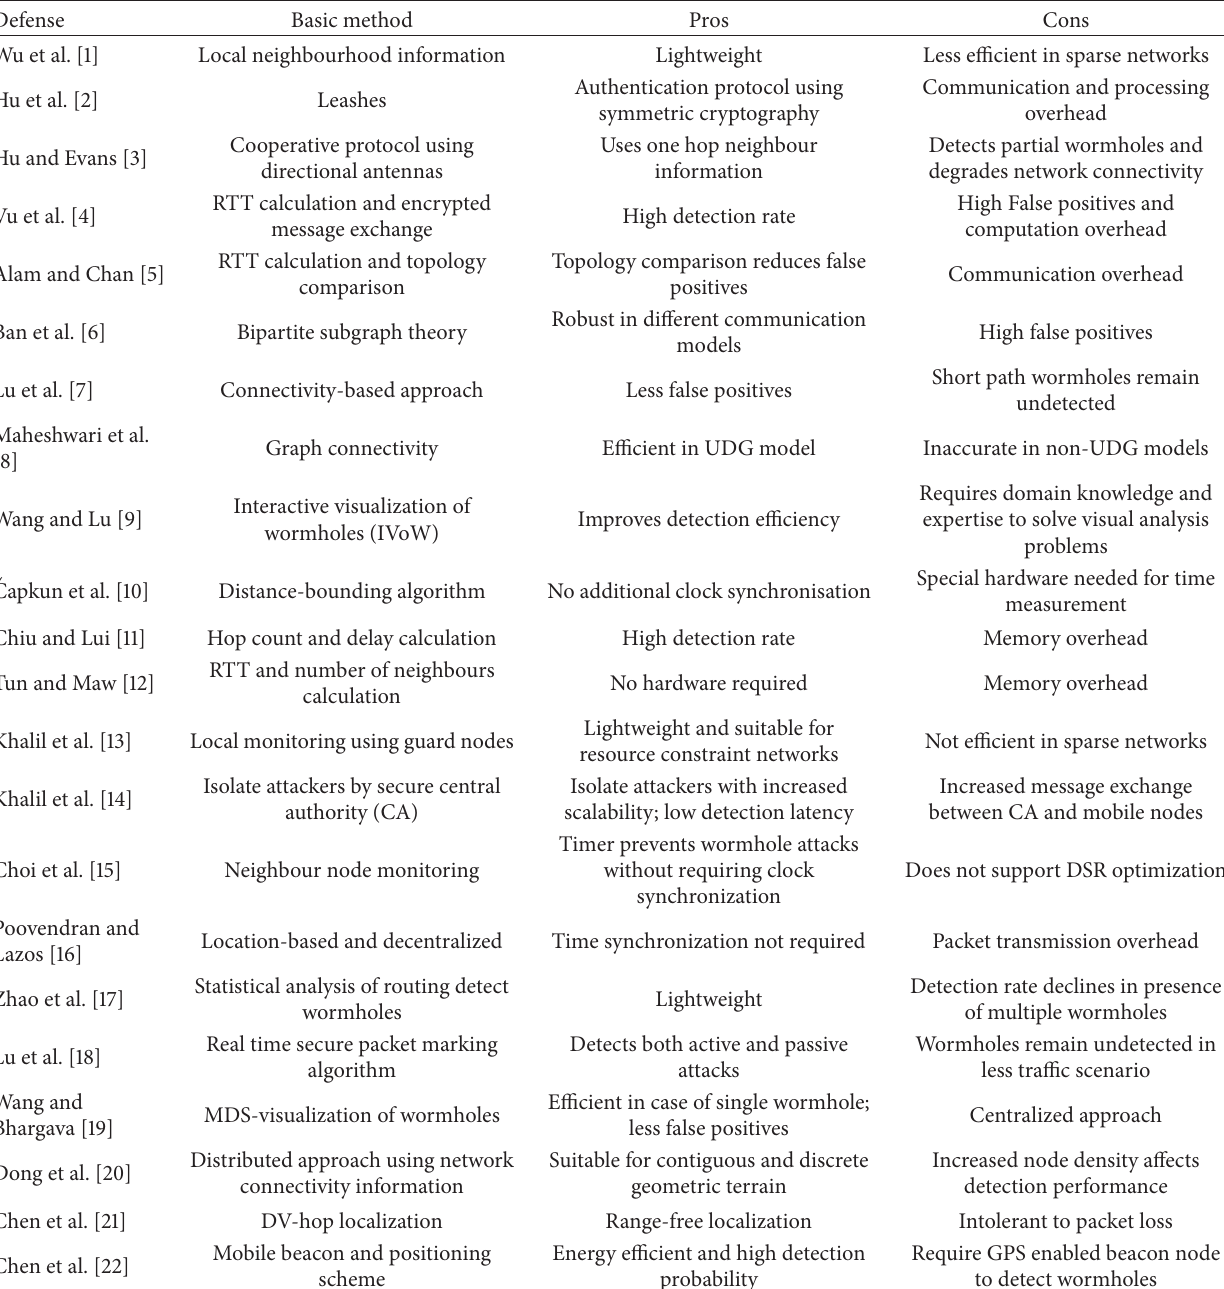
Table 1: Summary of different techniques to detect